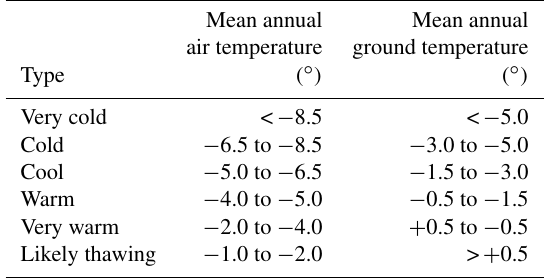
Table 1. Classification system used to assess permafrost thermal degradation (Modified according to Cheng,